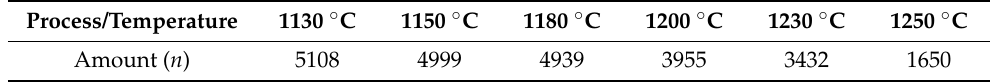
Table 1. The carbide quantity statistics for different quenching